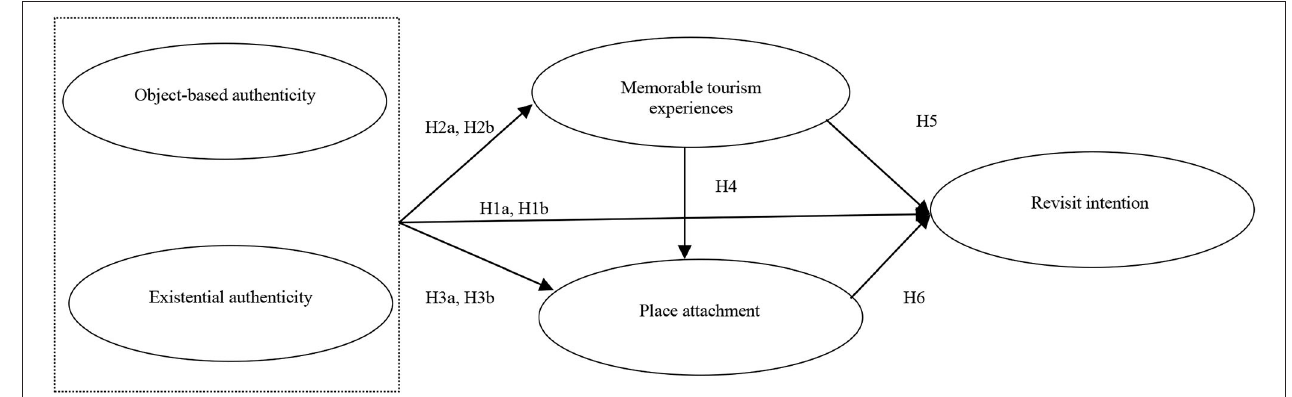
FIGURE 1 | Conceptual model.